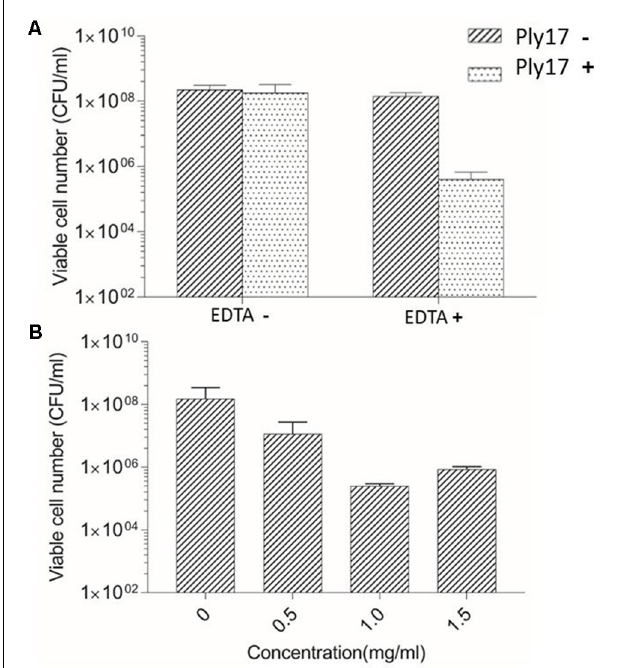
FIGURE 2 | Lytic activity of Ply17 against PAO1. (A) Ply17 (1 mg/ml) significantly reduced the EDTA-treated viable bacteria more than 2 logs, while Ply17 cannot kill PAO1 directly. (B) Lytic activity of different concentrations of Ply17 against PAO1. All experiments were repeated three times. The values are the means and standard deviations from triplicate